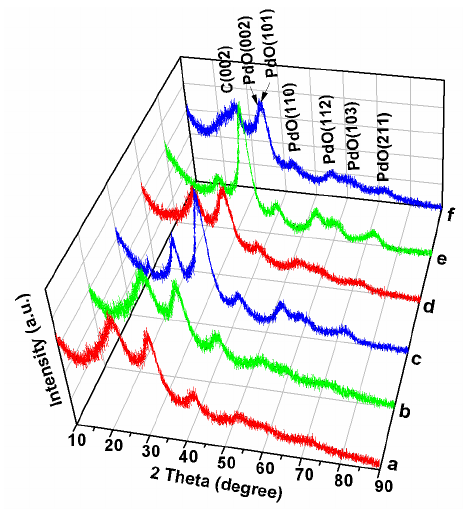
Figure 3. XRD patterns of pSWCNT/PdO (a), pDWCNT/PdO (b), pMWCNT/PdO (c), oSWCNT/PdO (d), oDWCNT/PdO (e), and oMWCNT/PdO (f).